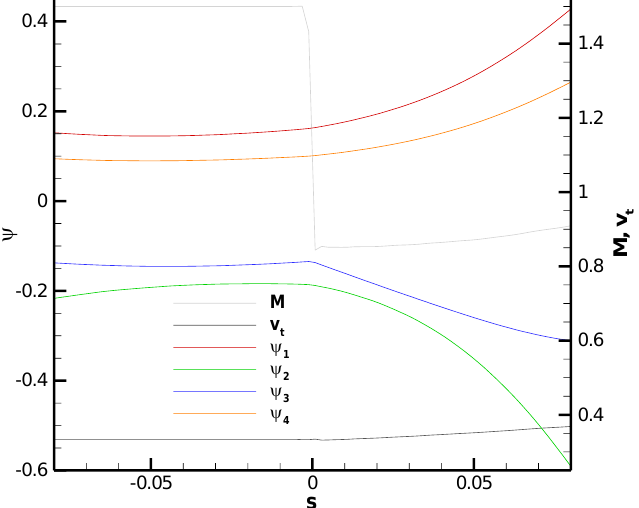
Figure 8. Flow past a NACA0012 airfoil at M = 1.5 and α = 0°. Adjoint variables along the cutting line indicated in Figure 7. Mach number and tangential velocity are also shown for reference.